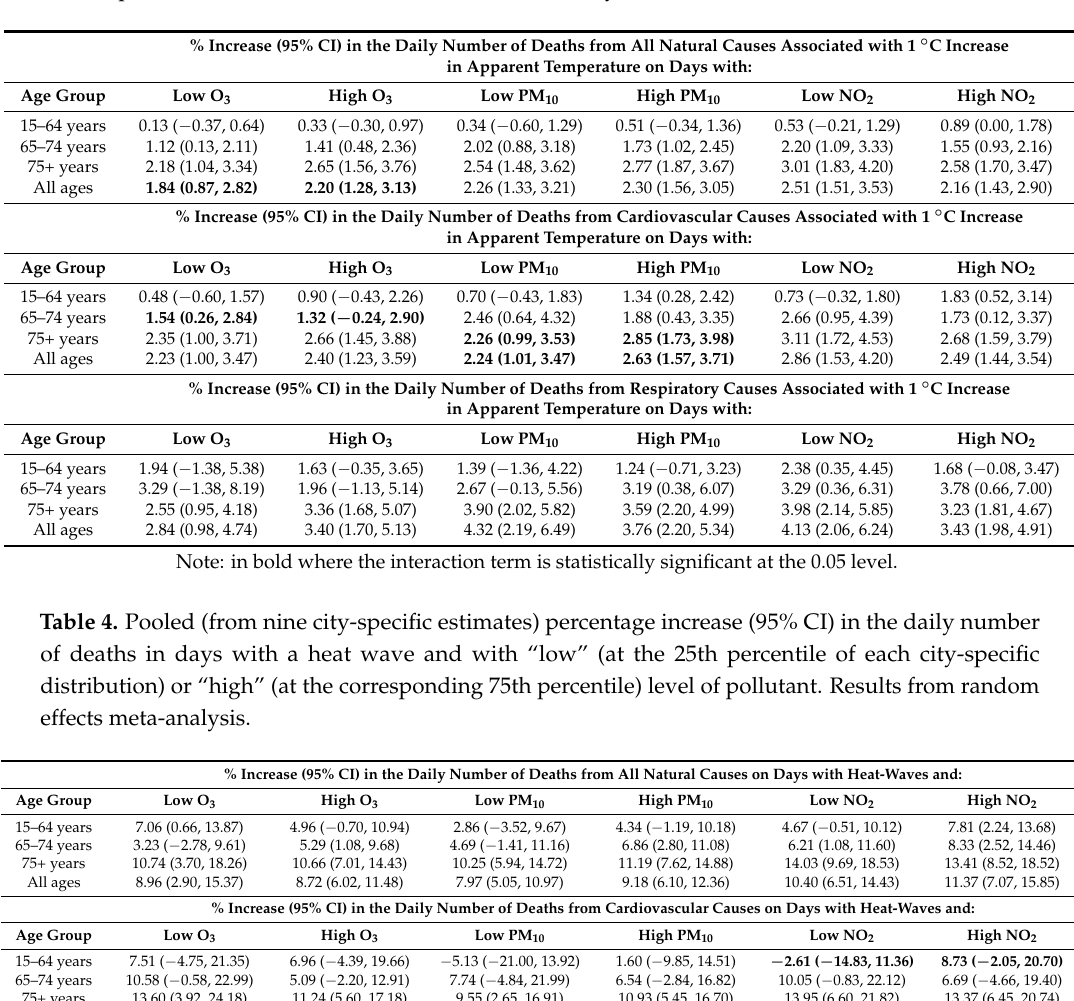
Table 3. Pooled (from nine city-specific estimates) percentage increase (95% CI) in the daily number of deaths per degree Celsius increase in apparent temperature in the warm period in days with “low” (at the 25th percentile of each city-specific distribution) or “high” (at the corresponding 75th percentile) level of pollutant. Results from random effects meta-analysis.